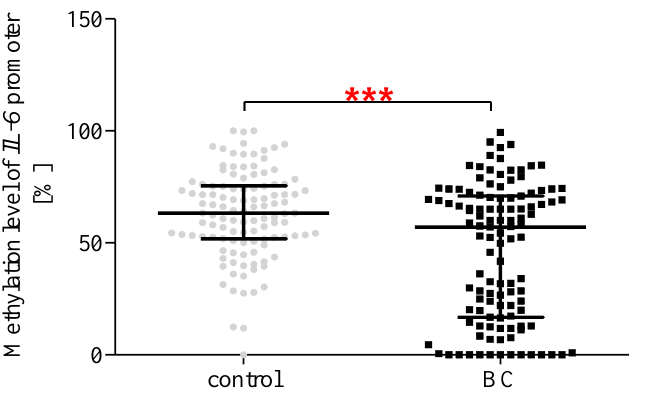
Figure 6. Methylation status of the IL-6 promoter region in PBMCs. The data are plotted as individual values and the median with interquartile range is indicated by the horizontal bars; ***— p < 0.001. 2.14. Methylation of the IL-6 Promoter Region and Correlation with Size or the Direct Extent of the Primary Tumour, the Status of Lymph Node Metastasis, Distant Metastasis According to the TNM Classification, and the Grading of Histological Malignancy We verified the impact of primary tumour size (Figure 7A), the status of lymph node